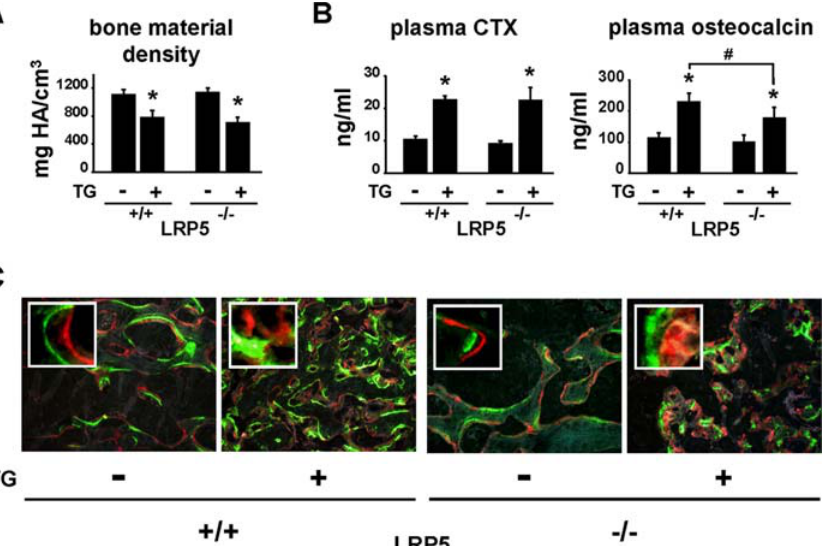
Figure 6. The High Bone Remodeling Phenotype of DMP1-caPTHR1 Mice does not Require LRP5. (A) Osteocalcin and CTX measured in plasma from 12-week-old LRP5 + / + and LRP 2 / 2 mice, with and without the DMP1-caPTHR1 transgene. Both sexes were included. (B) Bone material density as determined by micro-CT analysis of femurs from LRP5 + / + and LRP 2 / 2 mice, with and without the DMP1-caPTHR1 transgene. Bars represent the mean 6 SD of 3–5 mice/group. * p , 0.05 vs. LRP5 + / + mice without the transgene; # p , 0.05 vs. LRP5 + / + mice with the transgene. (C) Representative images of histologic sections showing calcein and alizarin double labeling in femurs from LRP5 + / + and LRP 2 / 2 mice with and without the DMP1-caPTHR1 transgene.